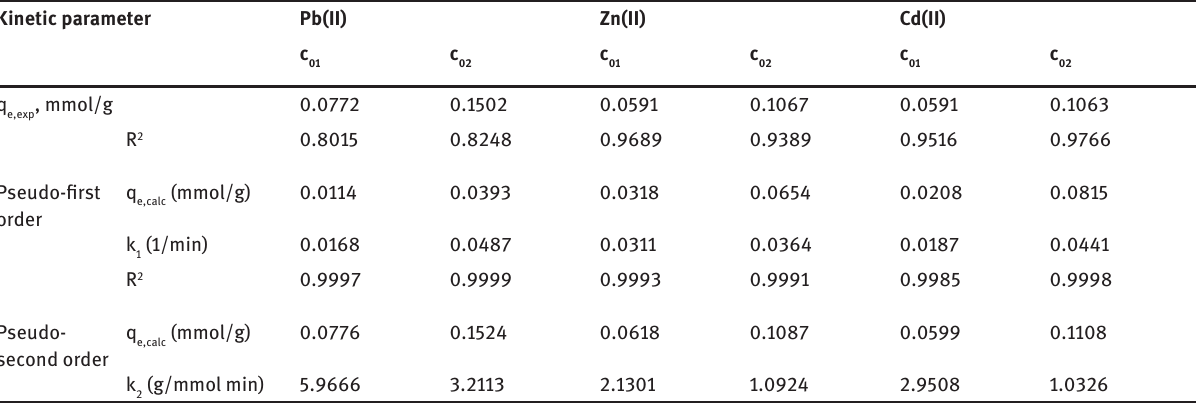
Table 3 : Kinetic parameters for the biosorption of Pb(II), Zn(II) and Cd(II) onto mustard waste biomass. Kinetic